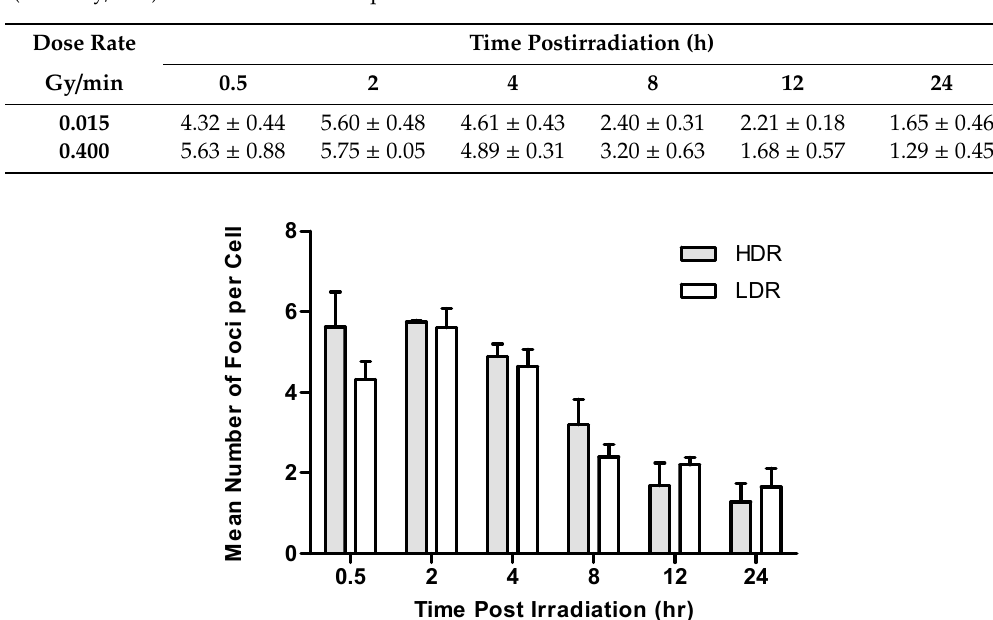
Figure 3. The number of γ -H2AX foci as a function of dose for human lymphocytes exposed to 1 Gy of HDR (0.400 Gy / min) and LDR (0.015 Gy / min) neutrons. Data represents the mean number of γ -H2AX foci ± standard deviation of four healthy volunteers over two independent experiments.